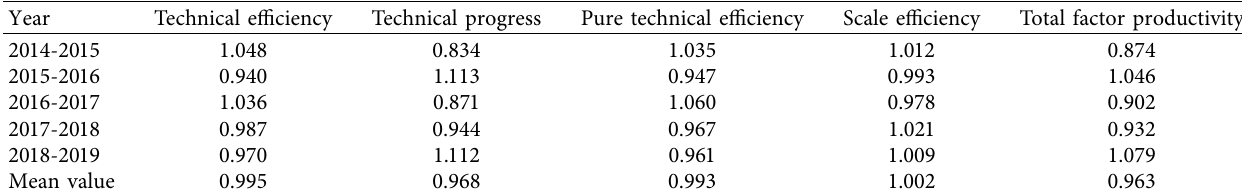
Table 4: Malmquist index of vegetable circulation in Henan Province from 2014 to 2019.